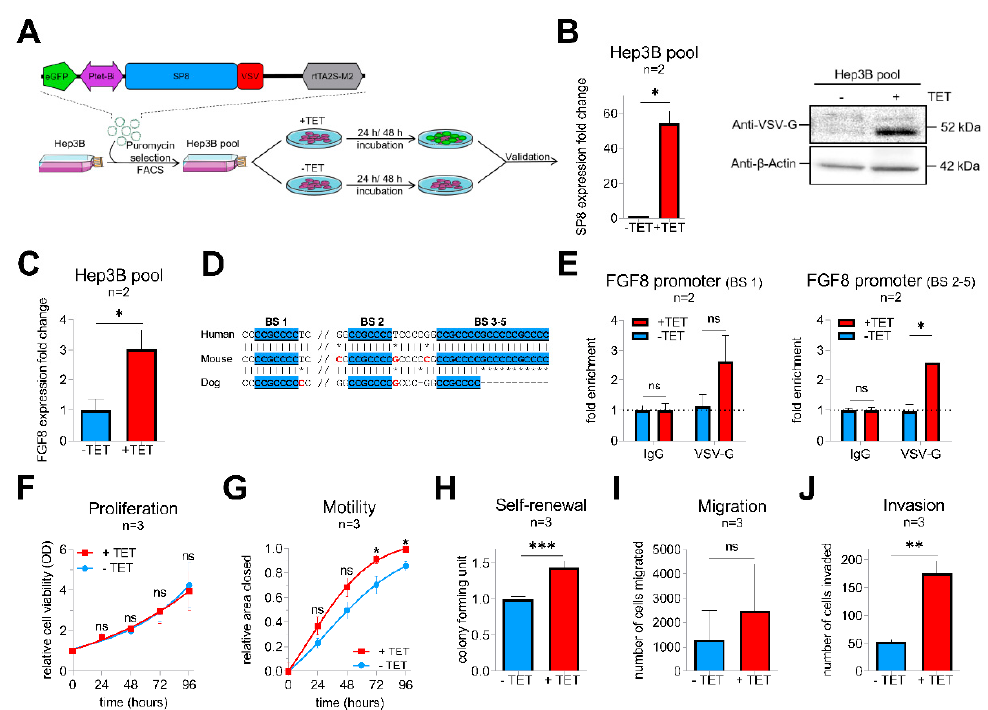
Figure 2. ( A ) schematic workflow of the validation approach of SP8 function in a Hep3B cell pool stably transfected with a TET-inducible SP8-eGFP-expression vector. Transfected cells were selected by puromycin treatment and enriched by fluorescence-assisted cell sorting (FACS). ( B ) SP8 overexpression 24 h after TET-induction was recognized by eGFP detection upon fluorescence microscopy (green cells) and proven on the RNA and protein level using Q-PCR and Western blotting, respectively. ( C ) FGF8 expression levels after stable SP8-induction in Hep3B pool cells for 48 h was measured by Q-PCR (normalized to TBP ). ( D ) schematic overview of the putative SP8 binding sites one to five upstream of the FGF8 promoter predicted from the SP1-binding motif (GGGGCGG or CCGCCCC), highlighted in blue. ( E ) Chromatin immunoprecipitation was performed with Hep3B pool cells 48 h after TET-induction using an anti-VSV-G antibody or IgG control. Enrichment of VSV-SP8 binding on DNA fragments containing the putative SP8 binding site (BS) 1 (left panel) and BS2-5 (right panel) versus IgG background is plotted. Assays for ( F ) proliferation, ( G ) motility, ( H ) self-renewal, ( I ) migration and ( J ) invasion were conducted to validate tumor cell characteristics of TET-induced Hep3B cells. Means ± SEM were calculated from the indicated number of independent experiments. Statistical significance of all experiments was calculated using Mann–Whitney test (* p < 0.05, ** p < 0.01, *** p < 0.001).